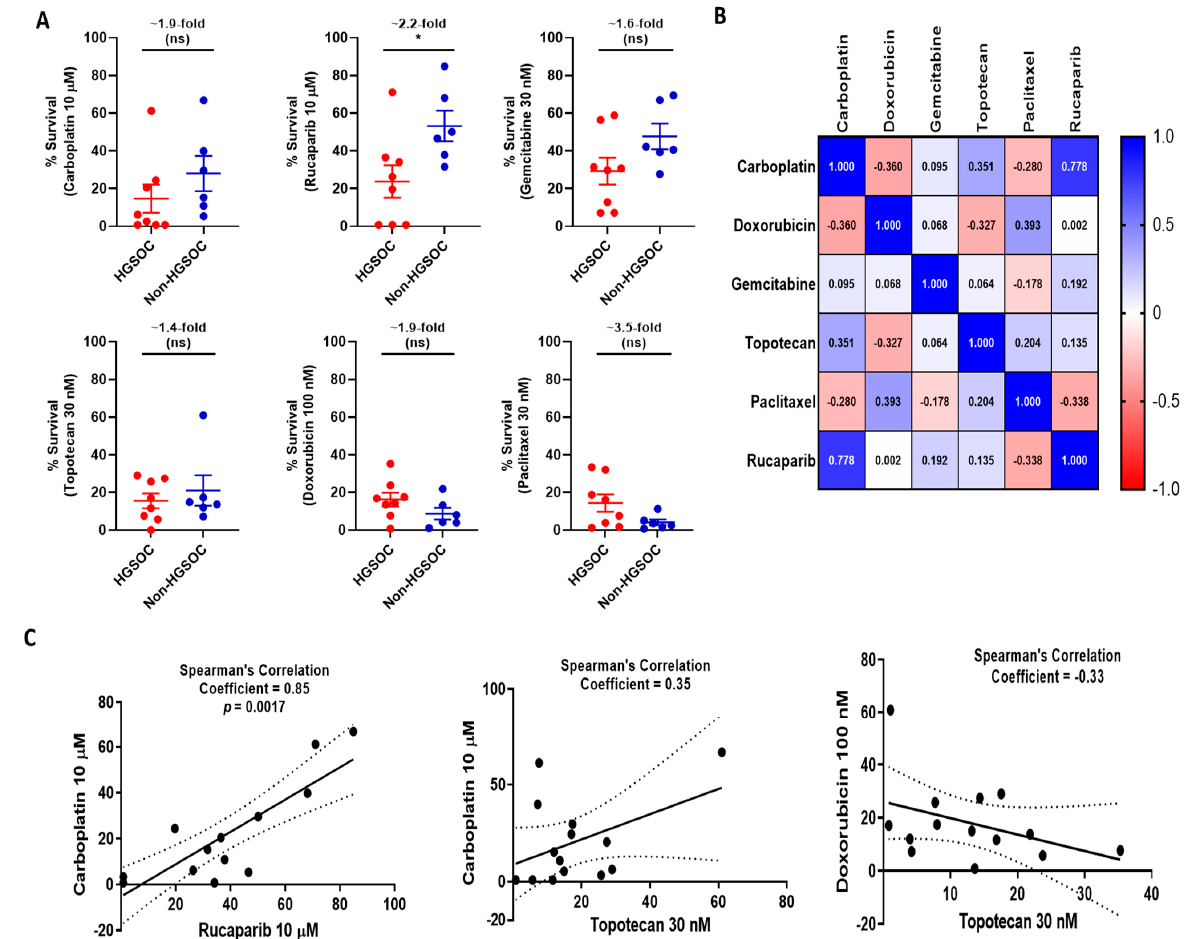
Figure 2. High grade serous (HGSOC) and non-high grade serous (Non-HGSOC) cell lines show distinct differences in their sensitivities to chemotherapeutic agents with different drugs correlating differently with others. ( A ) Survival of the HGSOC compared with the Non-HGSOC cell lines for carboplatin, doxorubicin, gemcitabine, topotecan, paclitaxel, and rucaparib. Plots represent the mean ± SEM of the % survival of cell lines in each group. Fold-changes are calculated between the mean of the two groups (ns: statistically non-significant; * p < 0.05) ( B ) Survival at fixed concentrations of drugs are shown in the heatmap, and hierarchical clustering identified a strong association between carboplatin and rucaparib with topotecan being the next closest member. Gemcitabine, doxorubicin, and paclitaxel formed a second distinct sub-cluster ( C ). Correlation analysis identified a statistically significant correlation between carboplatin and rucaparib sensitivity. A positive correlation was observed between carboplatin and topotecan, and a negative correlation was observed between doxorubicin and topotecan (although statistically non-significant).